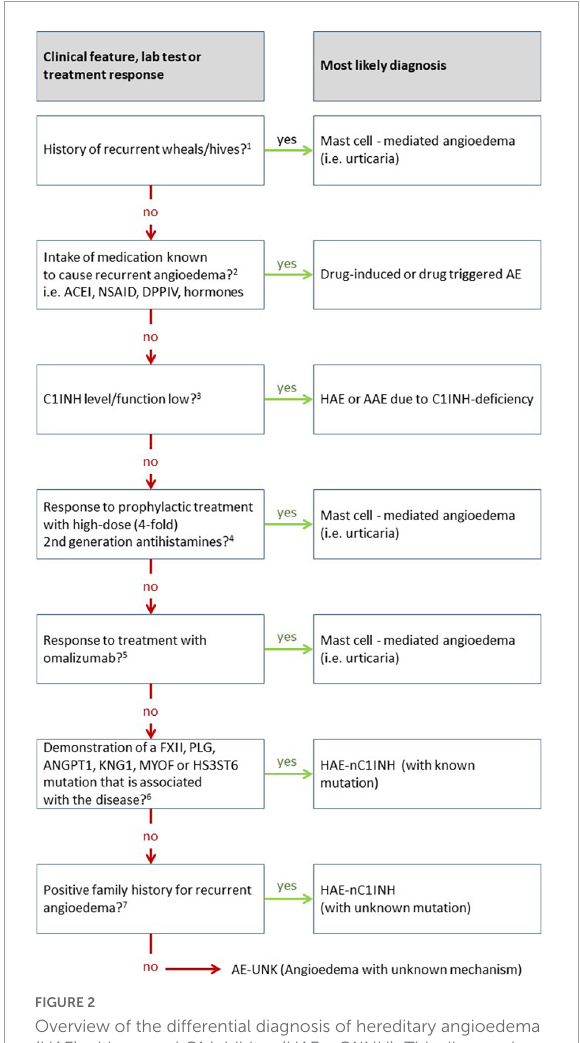
FIGURE2 Overview of the differential diagnosis of hereditary angioedema (HAE) with normal C1 inhibitor (HAE-nC1INH). This diagram is adapted from the work of Zuraw et al. (11), updated based on own experience, newly approved therapeutic options in the meantime, and additional mutations discovered since then. 1 The recurrent occurrence of short-lived pruritic wheals and angioedema (AE) in recent patient’s history is most suggestive of the presence of mast cell-mediated angioedema, i.e., chronic urticaria. However, the presence of wheals does not completely exclude the presence of another disease other like HAE, since urticaria, a very common disease, may also occur in association with HAE (approximately 1% of cases). 2 Medications can cause various forms of angioedema or trigger underlying diseases causing angioedema. For example, ACE inhibitors (ACEI) can cause swelling in otherwise healthy individuals but can also very reliably trigger swelling in patients with C1INH inhibitor deficiency. On the other hand, non-steroidal anti-inflammatory drugs (NSAID) can trigger swelling in otherwise healthy people, but also in many cases trigger angioedema flare-ups in patients with urticaria. 3 Angioedema due to C1INH inhibitor (C1INH) deficiency typically results in markedly decreased values for C1INH concentration and/or function. Borderline depressed results are not likely to attribute angioedema to C1INH deficiency. 4 Verification of the efficacy of antihistamines can be meaningfully evaluated by the administration of prophylaxis alone. The response of an as-needed therapy can rarely